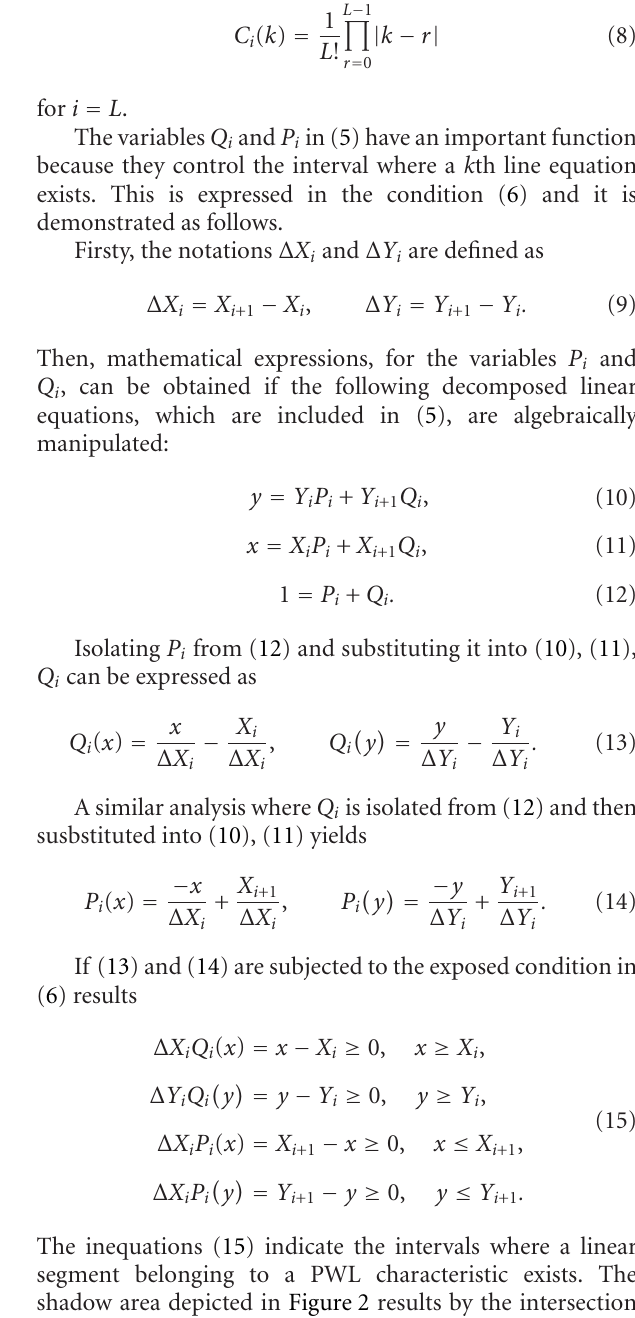
Figure 1: PWL characteristic and its graphic coordinates.